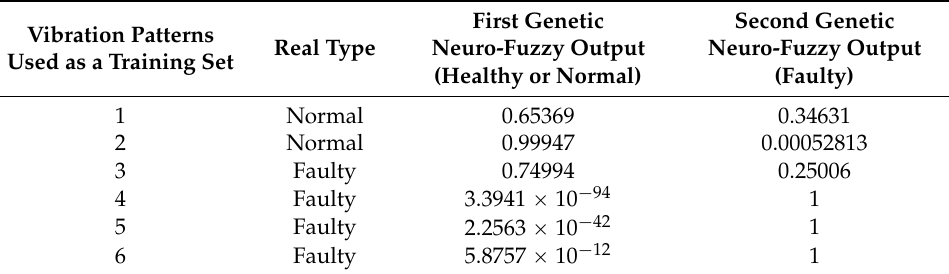
Table 2. Output values of the Genetic Neuro-Fuzzy system for the testing